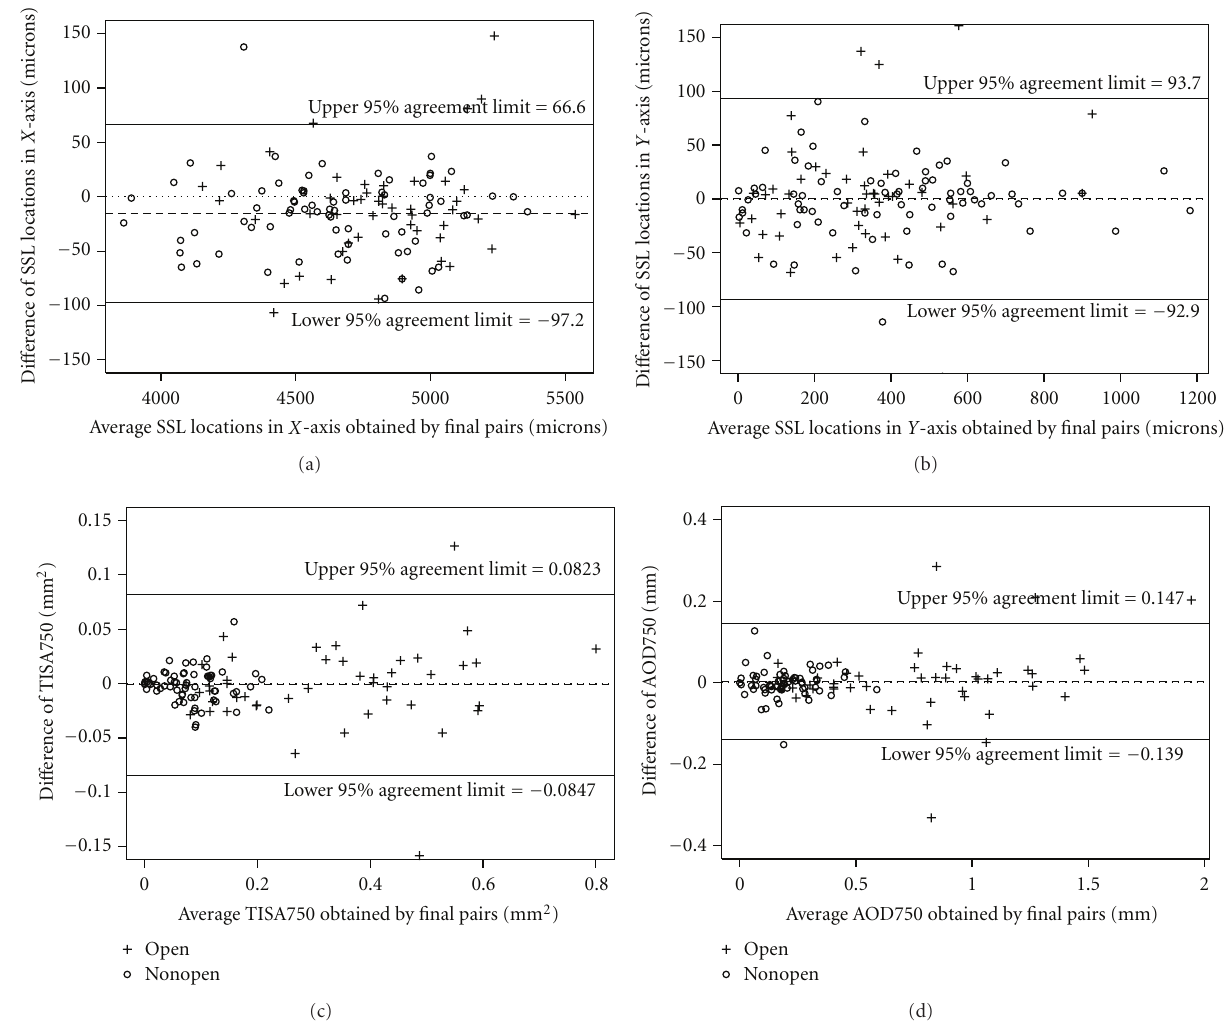
Figure 3: Bland-Altman agreement plots for adjudicated pairs for (a) SSL location in X -axis, (b) SSL location in Y -axis, (c) TISA750, and (d)